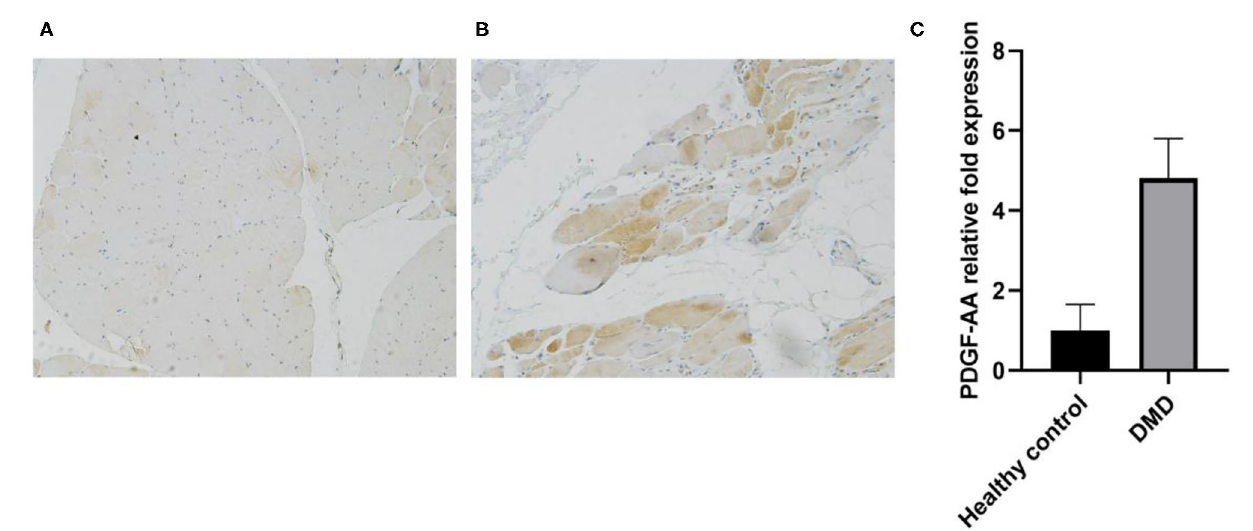
FIGURE 3 | PDGF-AA expression is increased in muscles of patients with dystrophinopathy. (A) PDGF-AA expression in skeletal muscles of healthy controls; (B) PDGF-AA expression in a muscle biopsy of a DMD patient and (C) Real Time PCR showing PDGF-AA mRNA expression in skeletal muscle samples of controls and patients with dystrophinopathy. Bars show mean mRNA expression and standard